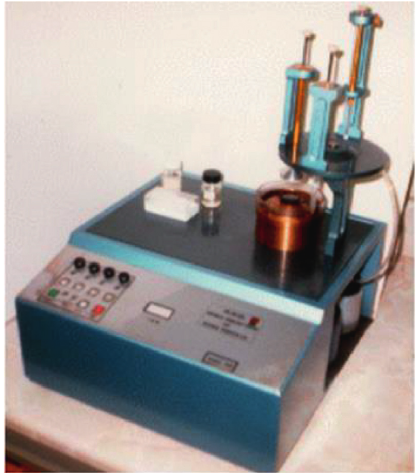
Figure 4: The rotary particle